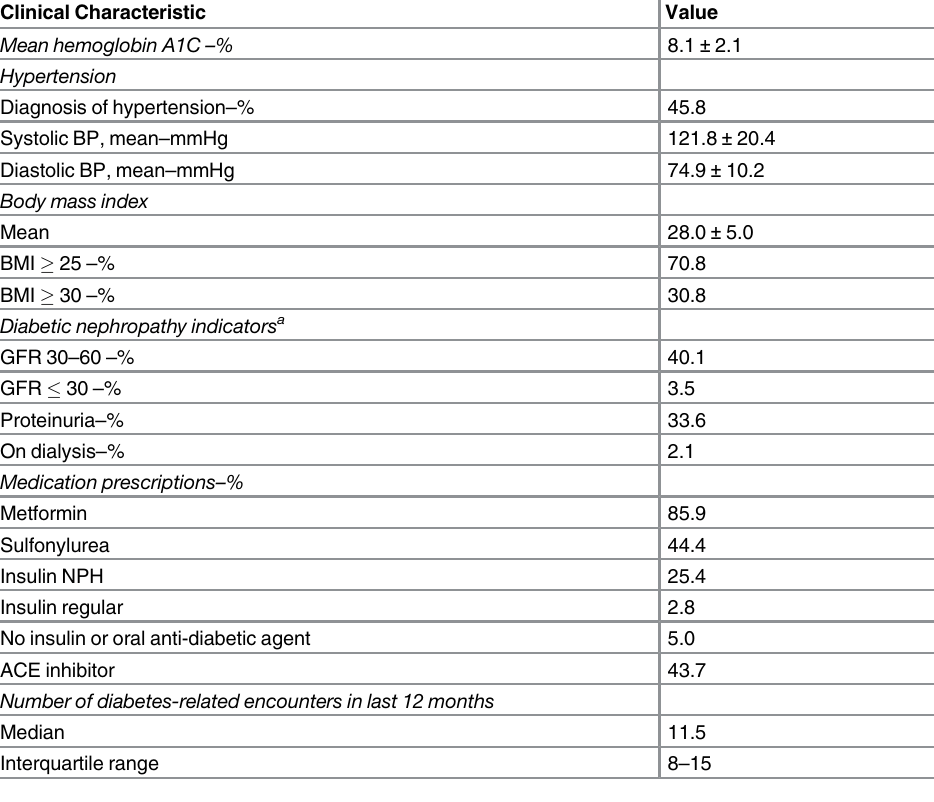
Table 3. Clinical profile of Type 2 Diabetes Cohort. Clinical